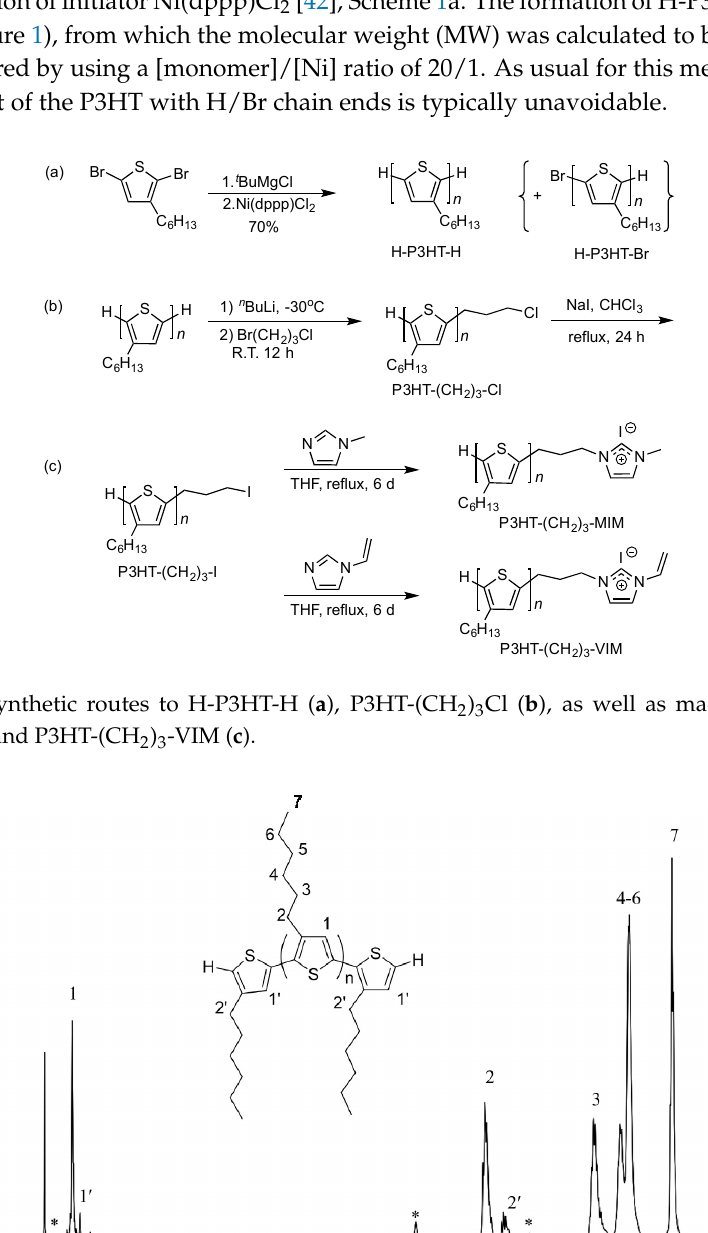
Figure 1. 1 H-NMR (400 MHz, CDCl 3 ) spectrum of H-P3HT-H with MW = ~2000 g/mol. Peaks marked * correspond to residual solvent signals.